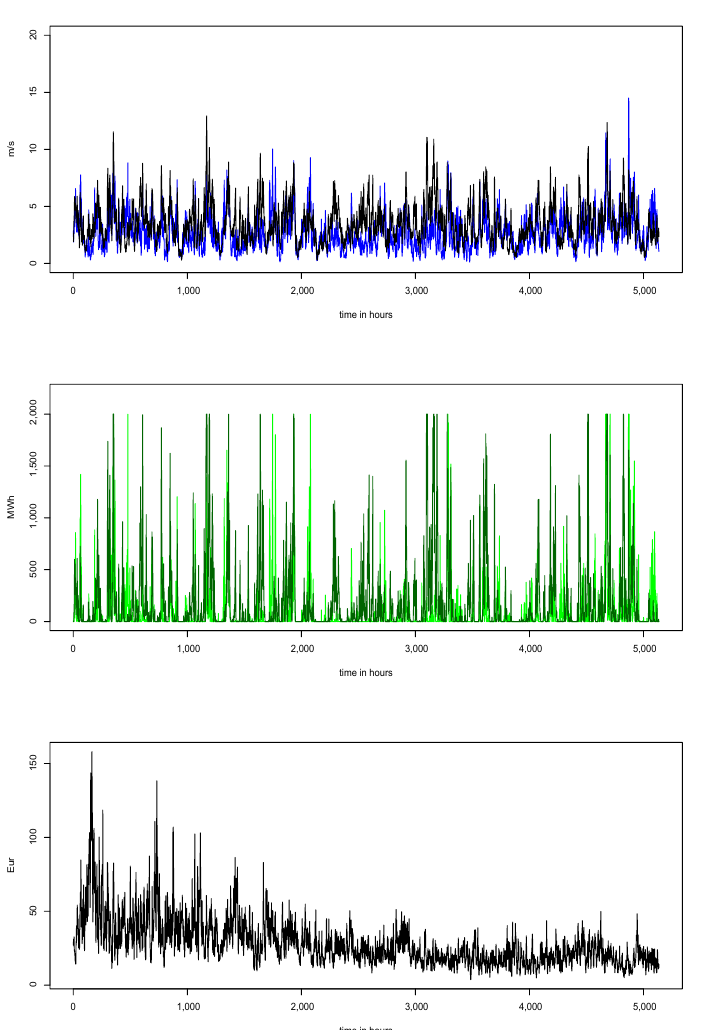
Figure 14. From the top down: two simulated trajectories of the wind speed of Paris and Nantes cross-correlated with each other (45.69%), which enter the power curve. Lastly, a simulated trajectory of the spot electricity price in France. Each simulation refers to the time horizon from 1 January 2019 to 2 August